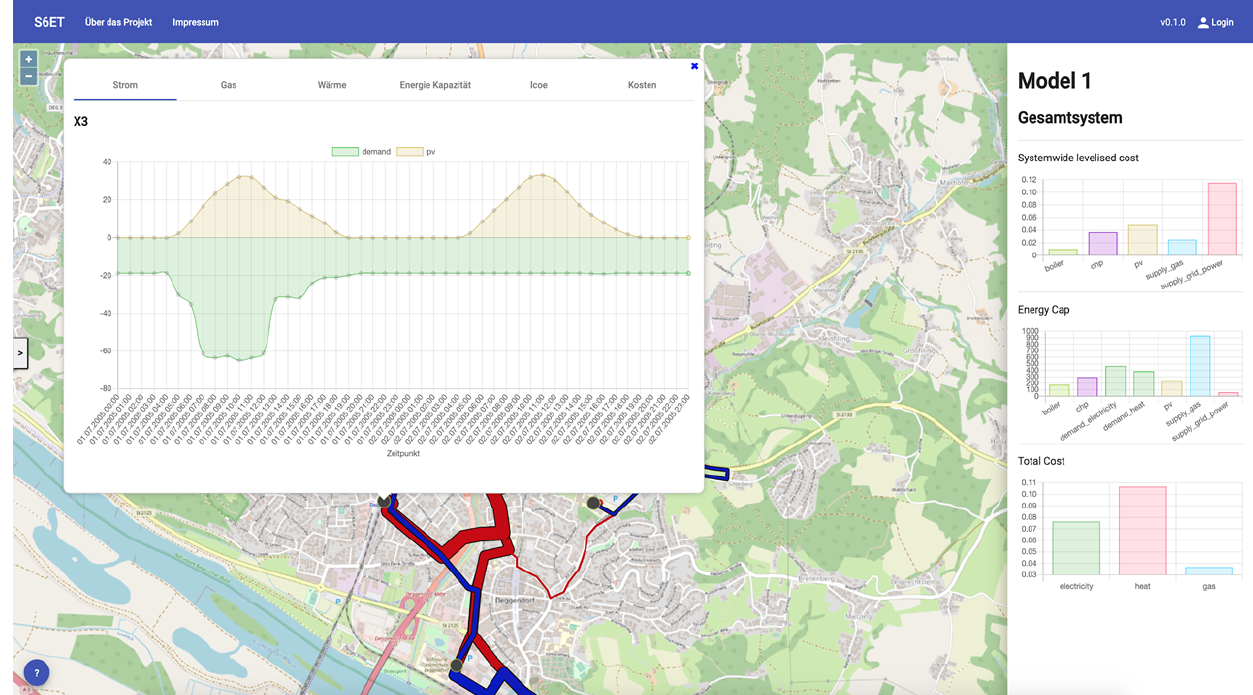
Figure 8. Angular web application containing the results of a simulation